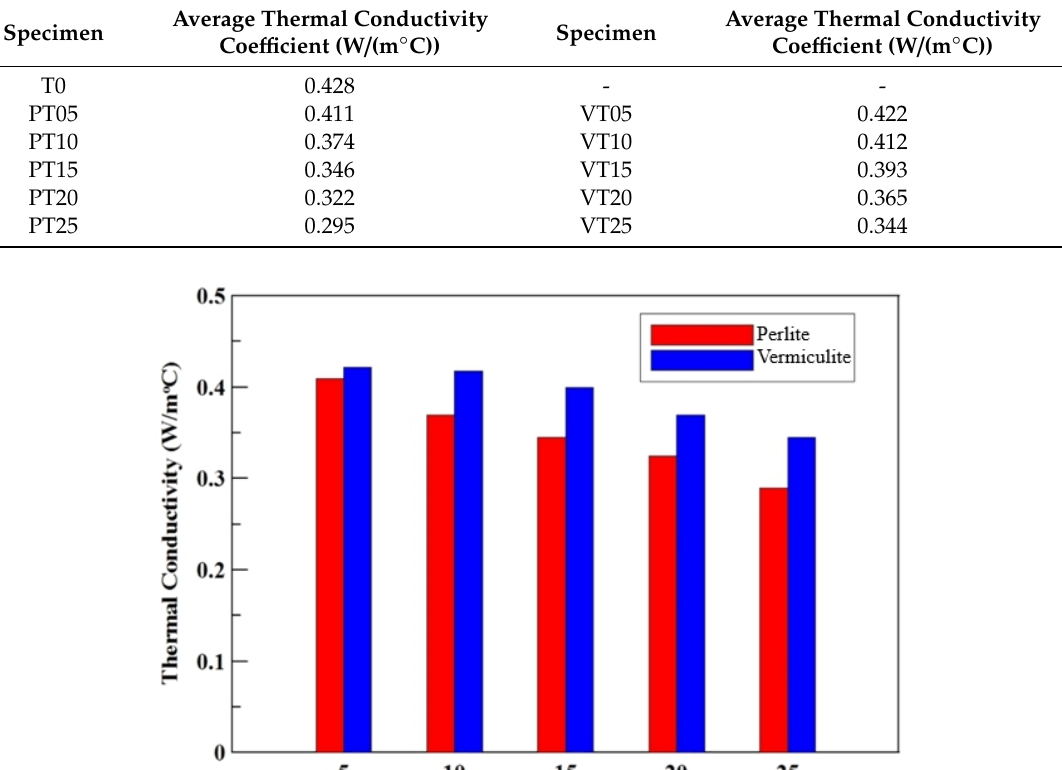
Figure 5. The relationship diagram between compressive strength and the content of perlite or vermiculite (by percentage weight) mixed with magnesium phosphate cement (MPC). Table 4. The average thermal conductivity coe ffi cient of the specimens.